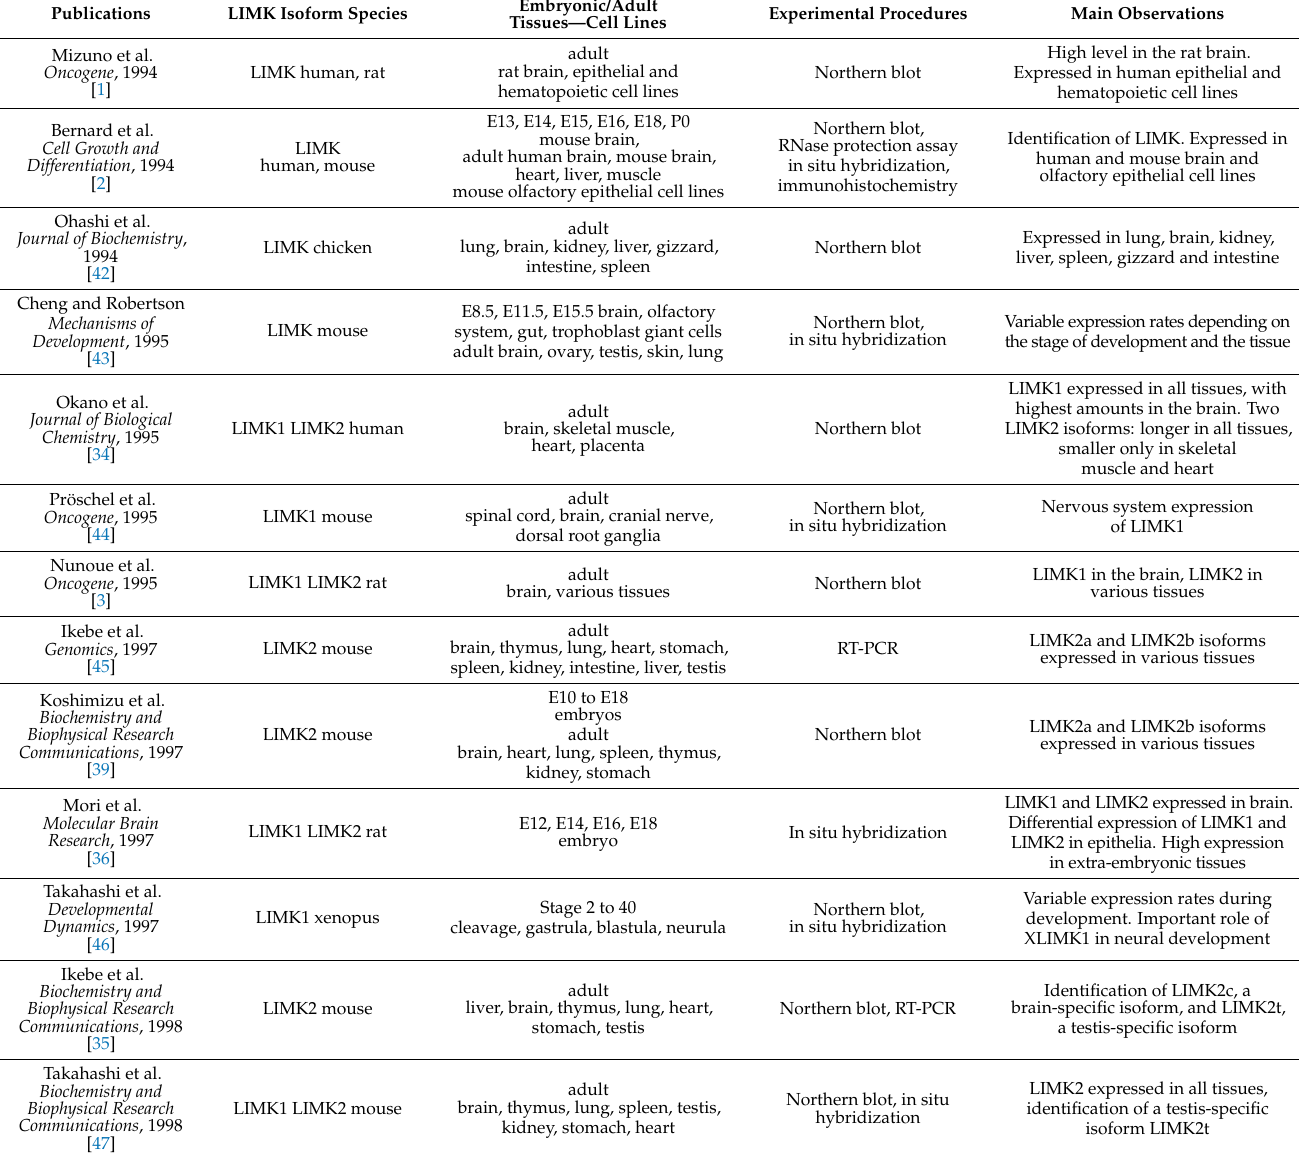
Table 1. Expression of LIMKs during